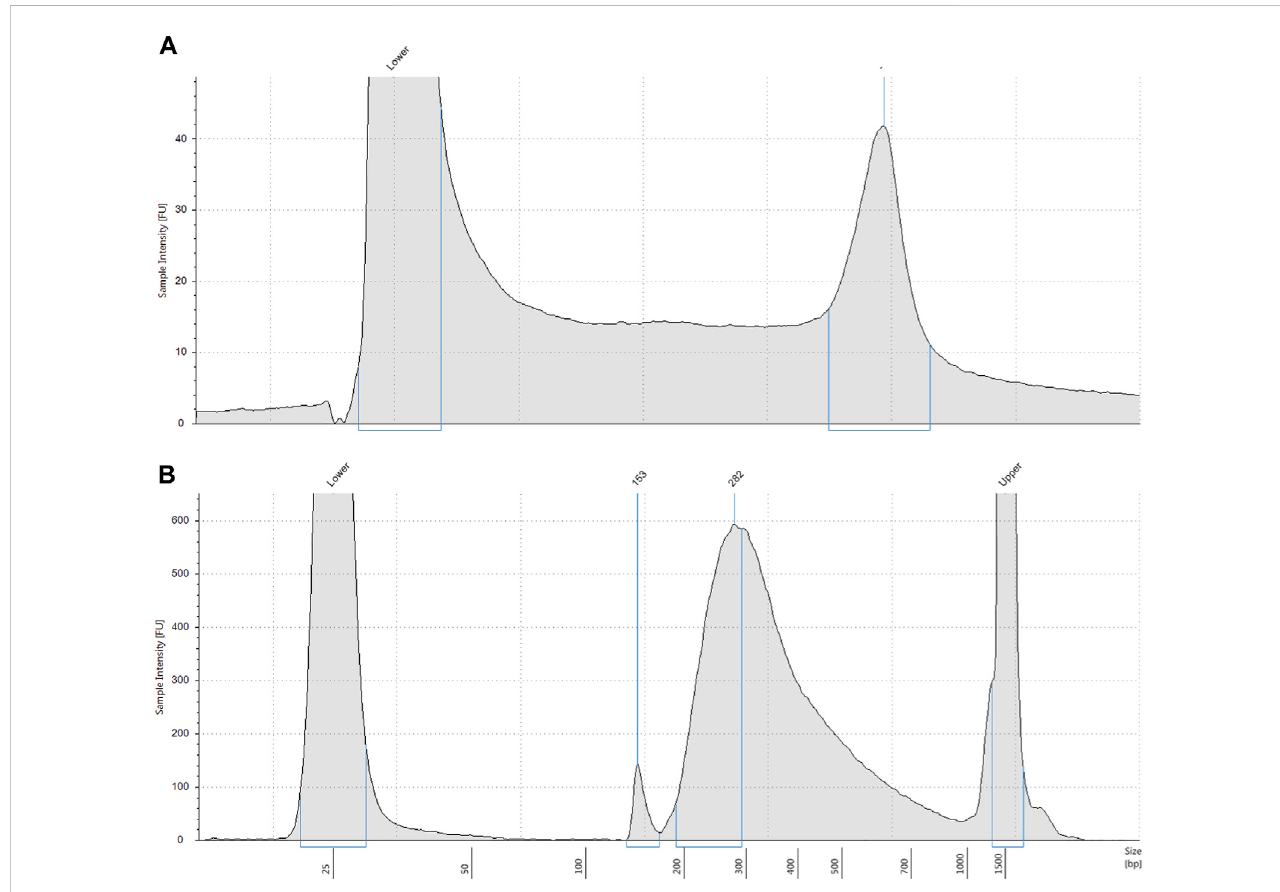
FIGURE 1 (A) Representative electropherogram pro fi le of genomic DNA extracted from DBS. Extracted DNA was analysed on a Tapestation 4200. DNA molecular weight is shown on the x -axis and intact high molecular weight DNA is shown by the right peak. Lower = low molecular weight standard. (B) Representative